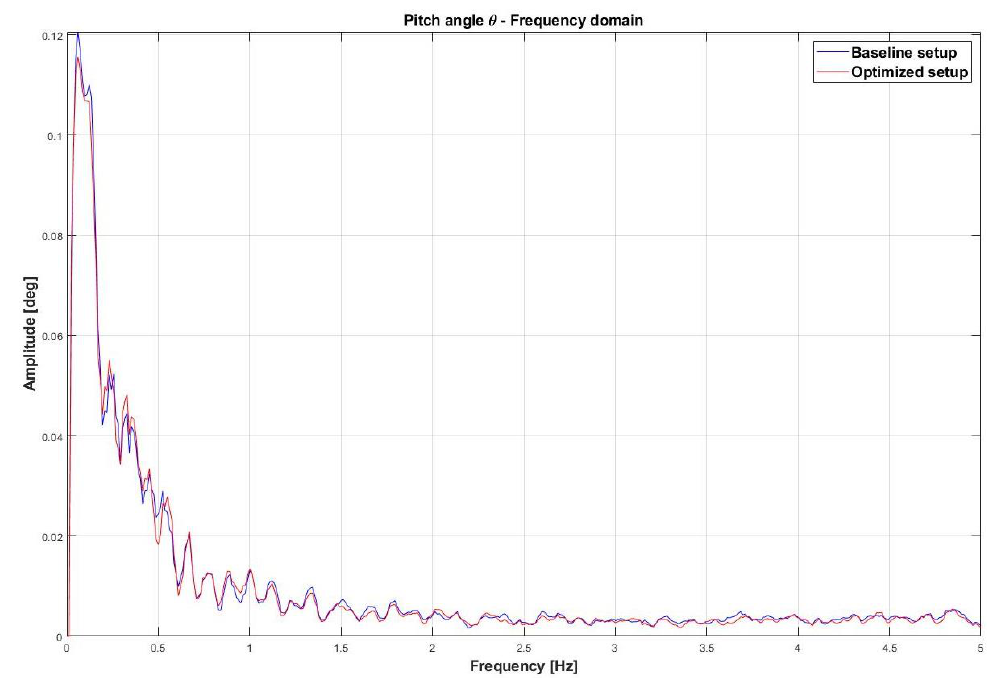
Figure 23. Comparison between the baseline provided setup and improved setup for the pitch angle trend in the frequency domain.